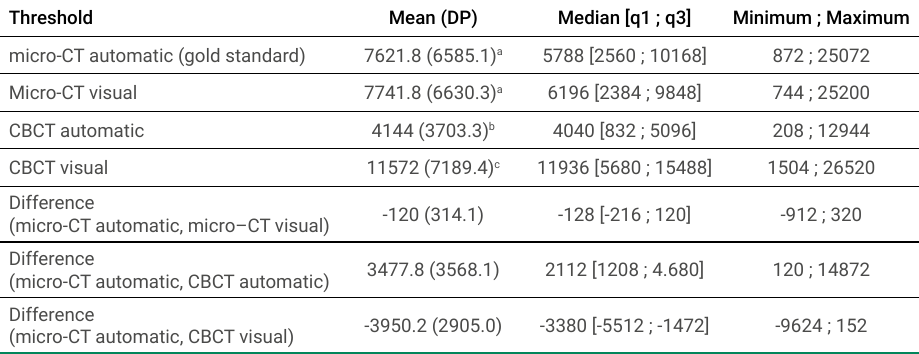
Table 1. descriptive data of root canal volume obtained for the tested groups. Mean, median, minimum and maximum root canal volumes (in voxels) for all threshold and acquisition methods are shown.